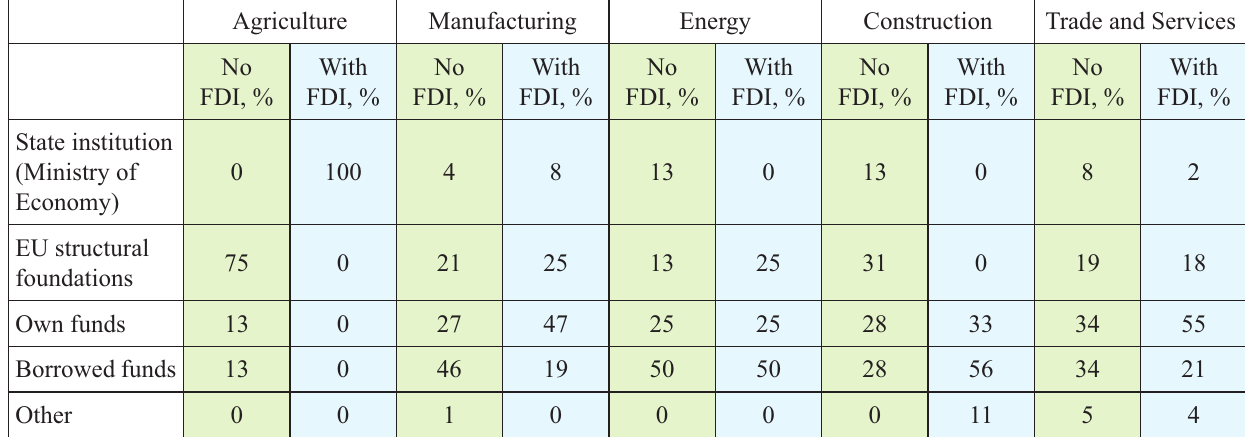
Table 2. Preferred instruments to fi nance new projects for businesses with and without FDI (What is your preferred instrument to